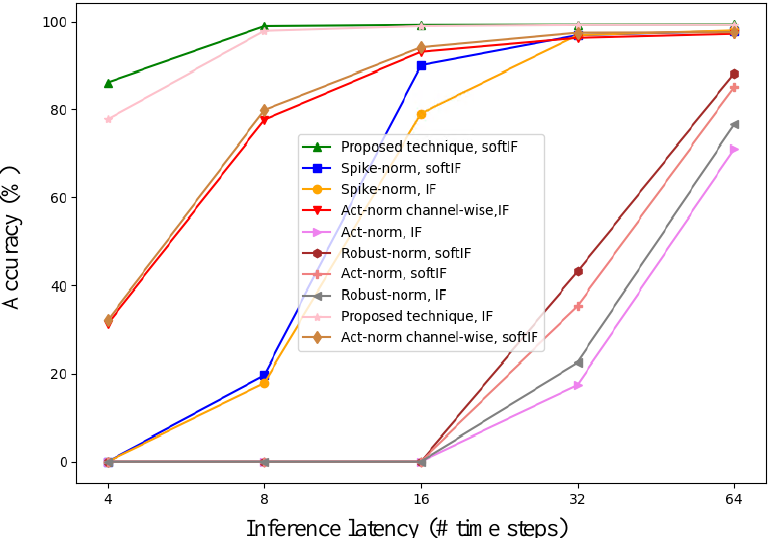
Figure 12. Performance of “SNN activation-threshold balancing technique” combinations for the MNIST